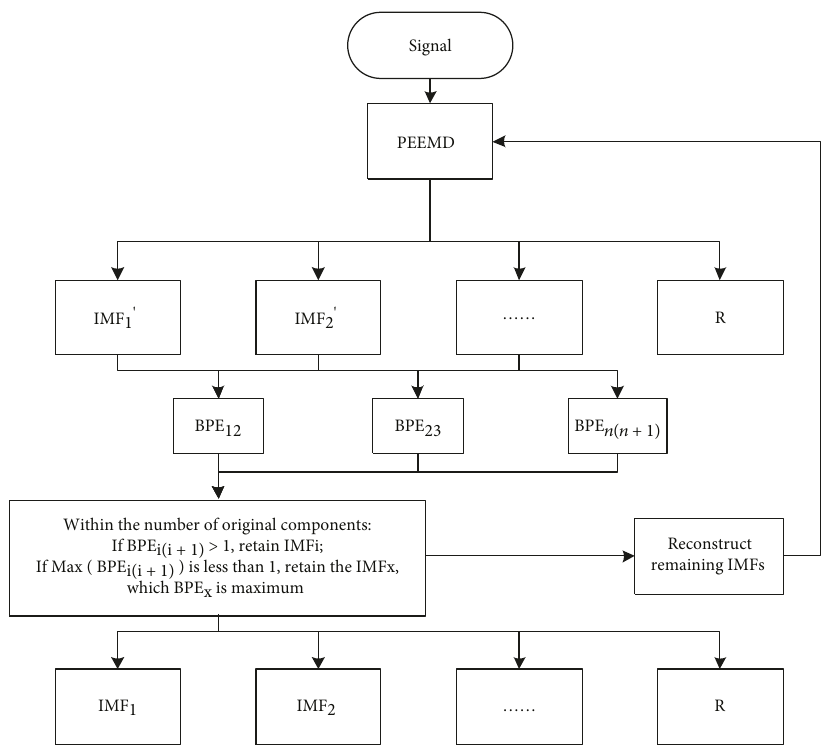
Figure 1: The scheme for eliminating mode splitting based on the PEEMD and BPE.